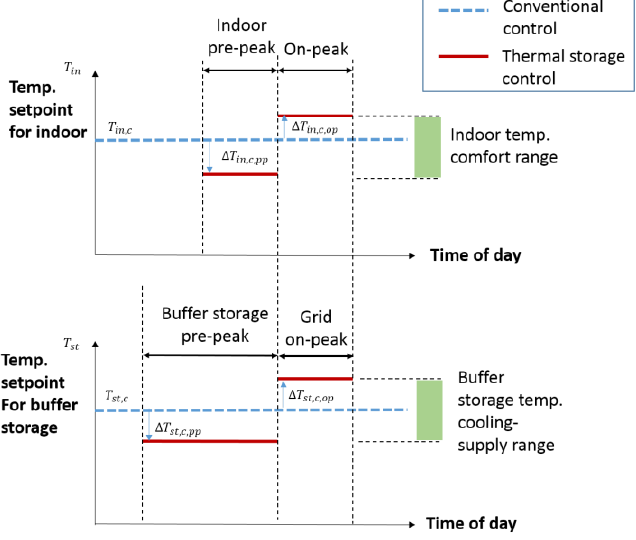
Figure 2. Schematic setpoint schedule for control strategies during cooling